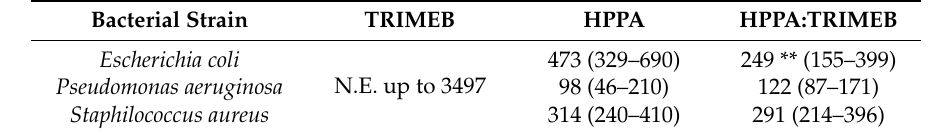
Table 2. Antimicrobial activity.